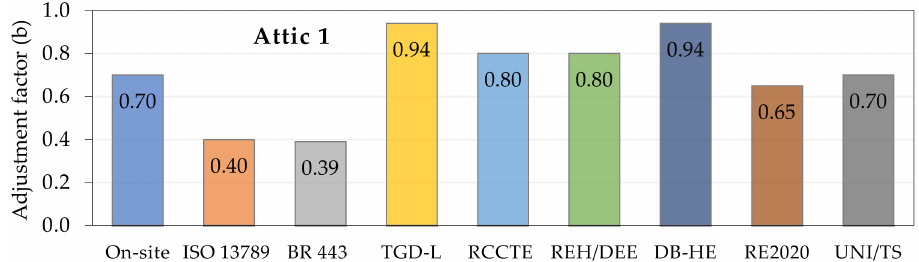
Figure 18. Comparison of the adjustment factor values (b) for Attic 1.